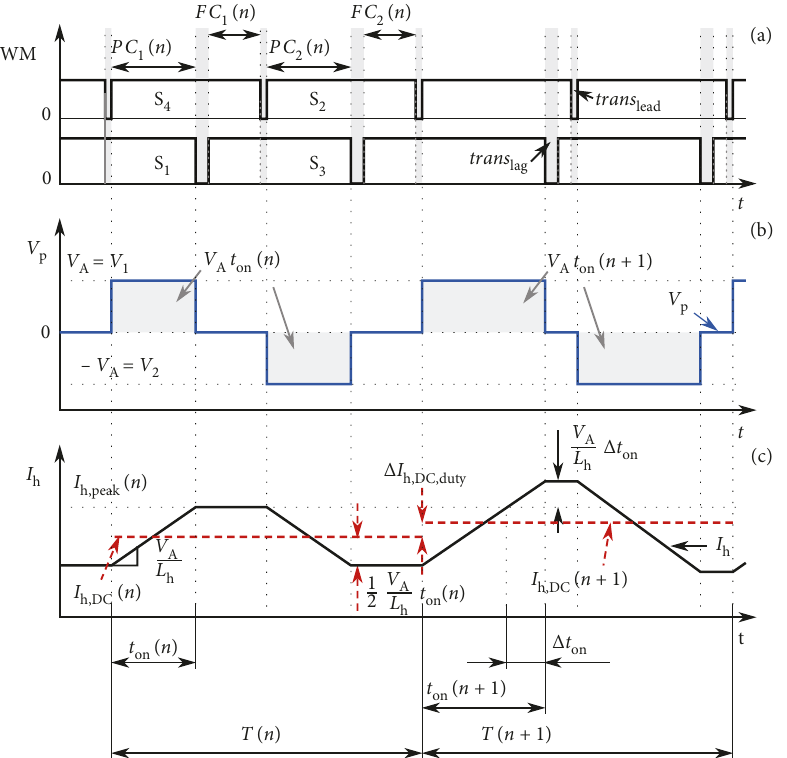
Figure 5: Influence of Δ d on Δ I over two periods T ( n ) and T ( n + 1 ) . According to phase shifted PWM signals for S 1 –S 4 in (a) the h , DC , duty applies to transformer shown in (b). In (c) the different duty cycles d voltage V p I ( n + 1 ) and I ( n ) h , DC h , DC